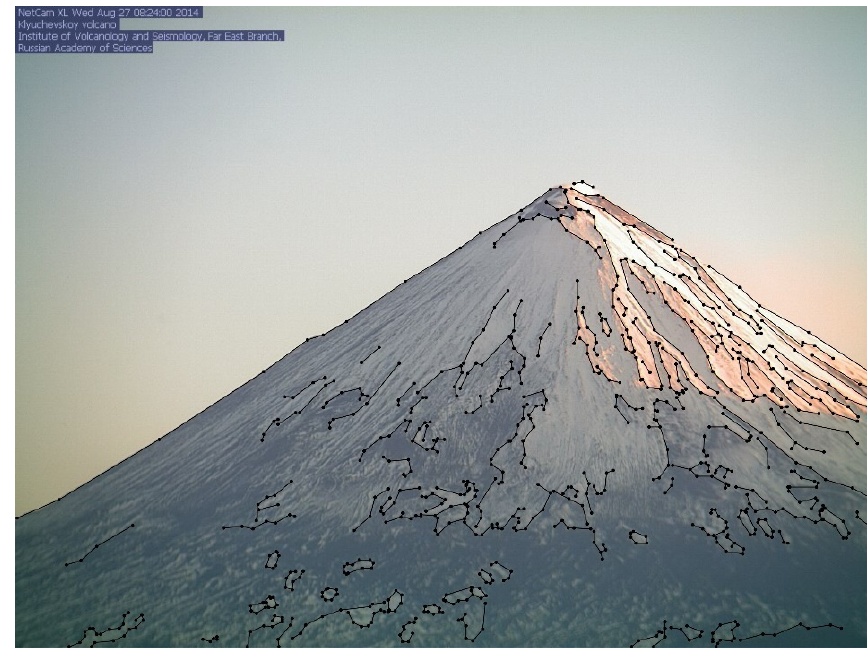
Figure 7. The example of parametric contours built for image of Klyuchevskoy volcano.